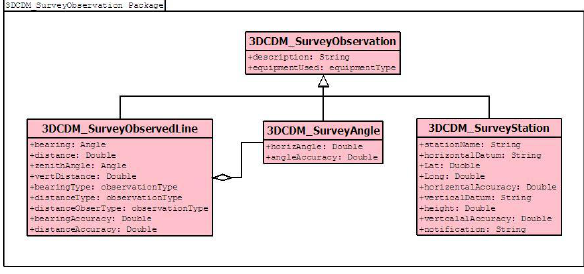
Figure 10. 3DCDM_Geometry Package (adopted from